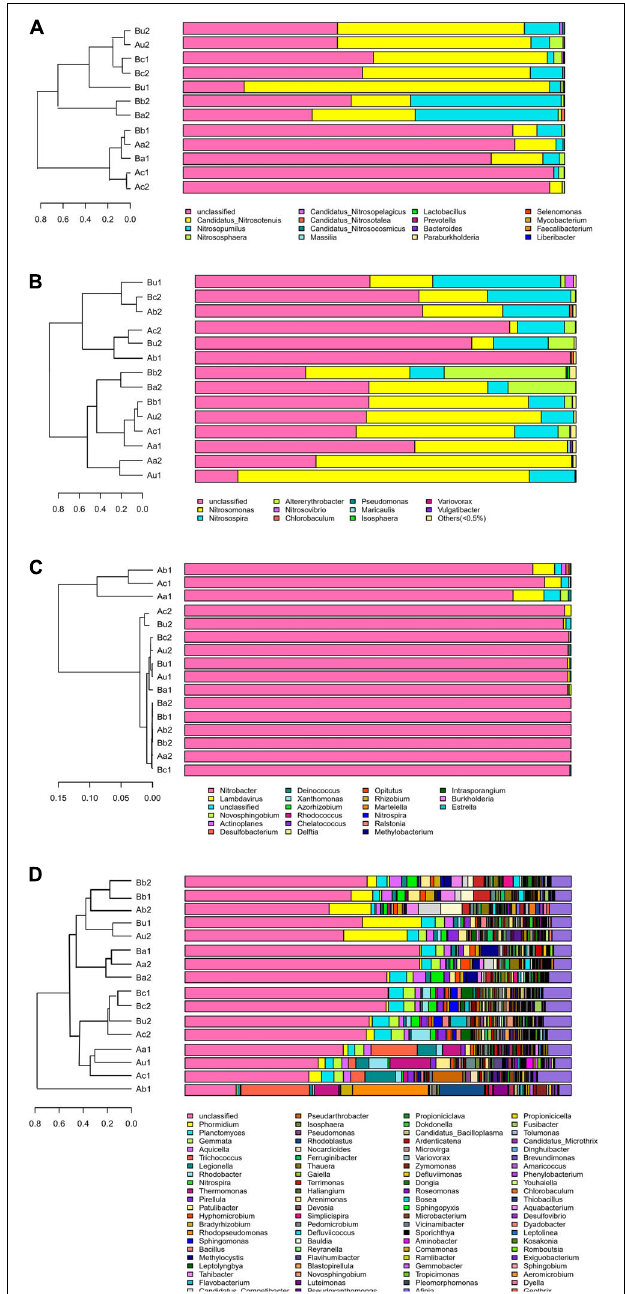
FIGURE 6 | Bar plot and cluster tree of microbial community of panels (A) AOA, (B) AOB, (C) NOB, and (D) 16S rRNA V4–V5